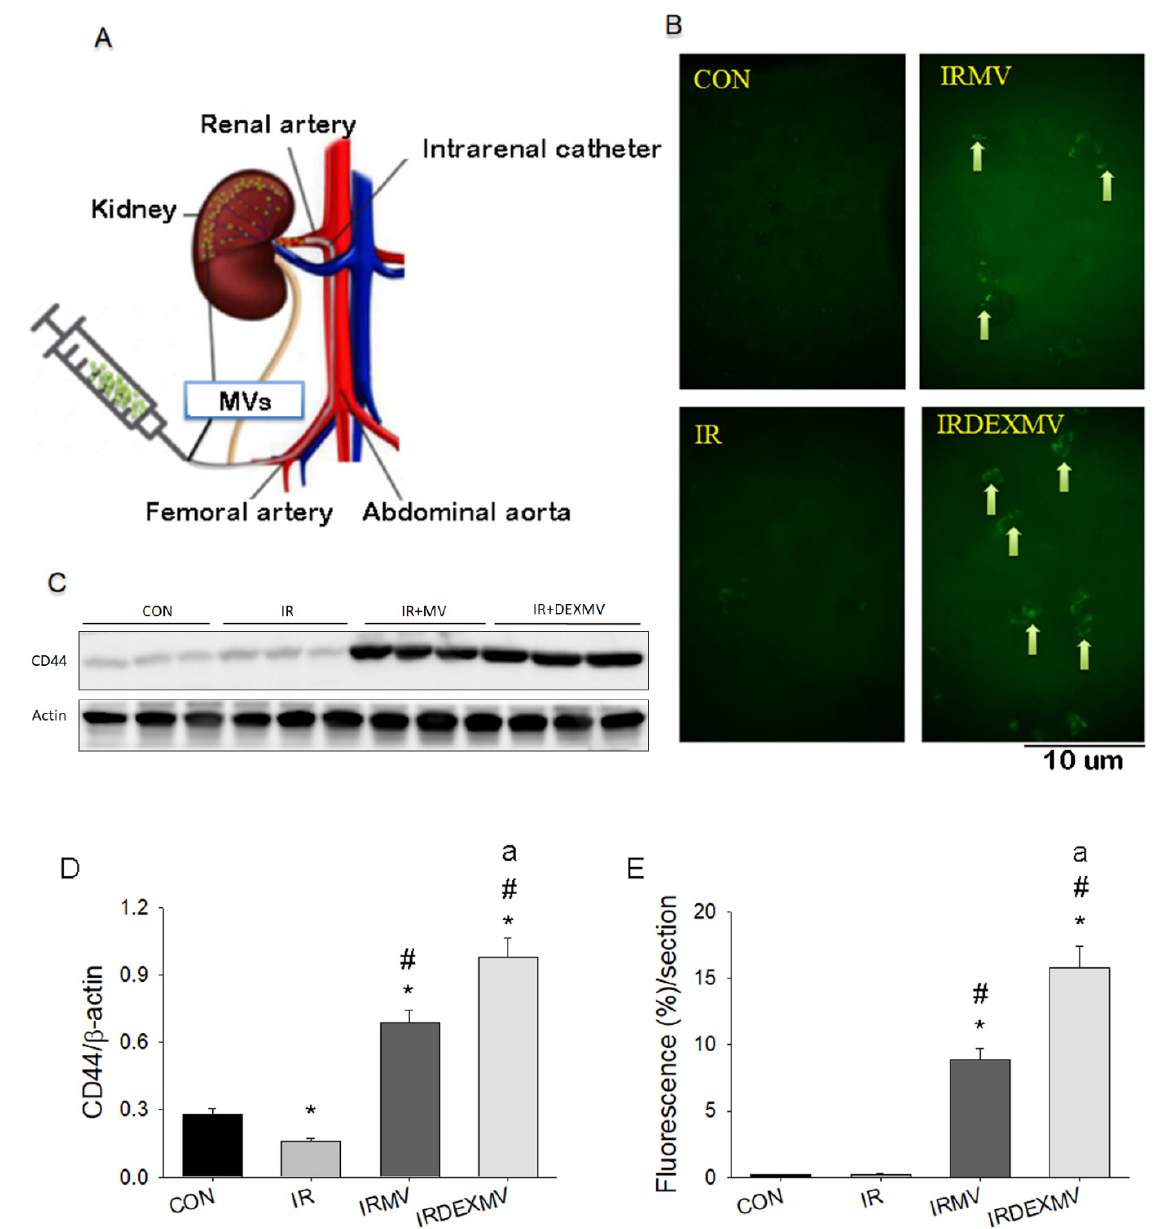
Figure 2. ( A ): The experimental protocol for intrarenal arterial injection of fluorescent MV to the kidney. ( B ): Detection of fluorescence expression in kidneys of rats treated with ADSC-derived MVs (n = 6). Representative fluorescent micrographs showing the expression of CD44 proteins in kidney sections of four groups of rats and sacrificed 1 h later. Original magnification: × 400. Arrows indicate fluorescent MVs. Six animals per groups were examined with similar results. ( C ): Western blot analysis of CD 44 expression of kidney homogenates in four groups of kidneys. ( D ): Statistical data of CD44 expression by Western blot (n = 3 each). ( E ): Statistical data of fluorescent MV expression of four groups of kidneys (n = 6 each). ADSC, adipose stem cell; MV, microvesicle; IR, ischemia/reperfusion; IRMV, ischemia/reperfusion with microvesicle. * p < 0.05 vs. CON rat. # p < 0.05 vs. IR rat. a p < 0.05 vs. IRMV